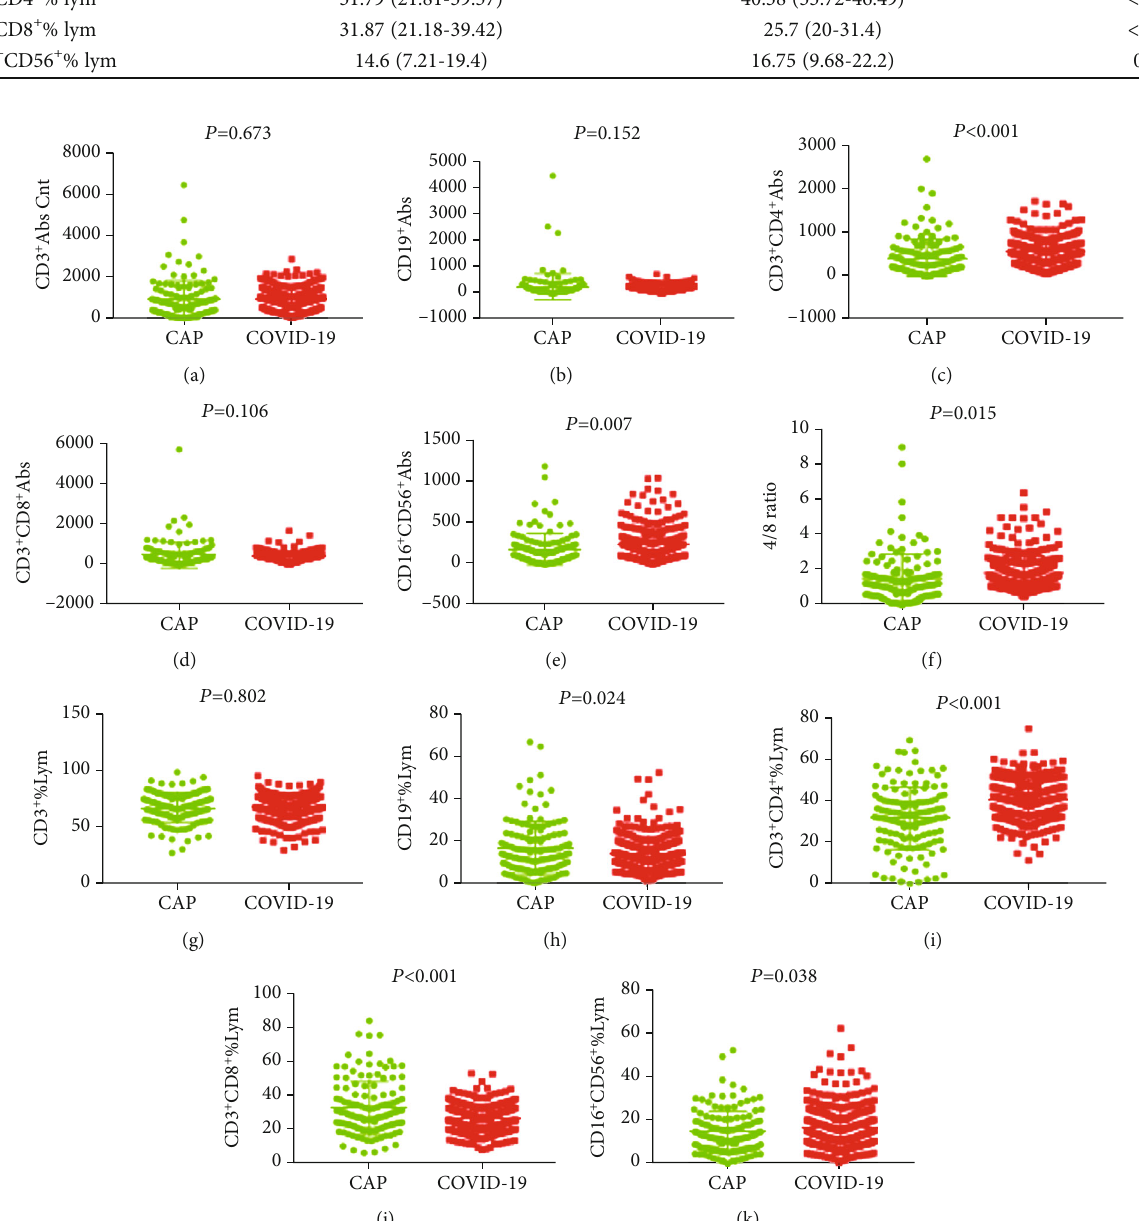
Figure 2: General characteristics of lymphocyte subpopulations between CAP patients and COVID-19